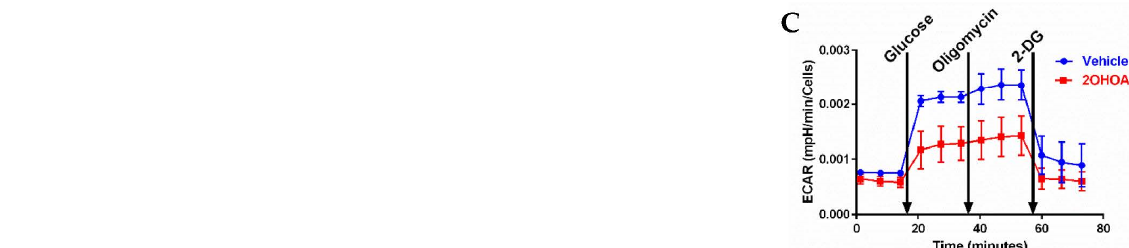
Figure 7. ( A ) Glycolytic (red) and mitochondrial (blue) ATP production determined by Agilent’s Seahorse machine and real-time ATP rate assay kit. U118MG cells were treated, or not (control), with 200 µ M 2OHOA for 48 h (chronic), or for 20 min on assay (acute). Readings were normalized to cell numbers as determined by Crystal Violet staining. Shown are mean and SEM values based on n = 3 repeats. Chronic treatment with 2OHOA led to complete depletion of glycolytic ATP production, while acute treatment significantly reduced respiratory ATP production ( p < 0.002) leaving glycolytic ATP production intact ( p < 0.92). These differences were inferred statistically by one-way ANOVA with Sidak’s post hoc correction. ( B ) Glycolysis estimated by NBDG (2-Deoxy-2-[(7-nitro-2,1,3-benzoxadiazol-4-yl)amino]- D -glucose) uptake into U118MG cells, as quantified by flow cytometry. U118MG cells were treated with 200 µ M 2OHOA for 48 h and then assayed for NBDG uptake as per the manufacturer instructions. Apigenin is a Glut 1 inhibitor and serves as a control for inhibition of NBDG uptake. Right panel shows quantification based on n = 3 experiments. ( C ) Glycolysis estimated by the Seahorse XF Glyco Stress kit based on n = 6 replicates. U118MG cells (~40,000 per well as determined by crystal violet staining) were treated, or not (vehicle), with 200 µ M 2OHOA for 48 h and their glycolysis was determined by extracellular acidification rate (ECAR) using the Seahorse XF Glyco Stress kit. Basal and maximal glycolysis were respectively estimated by supplementations of 10 mM glucose and 1 µ M oligomycin, while non-glycolytic ECAR was estimated by blocking glycolysis with 2-deoxyglucose